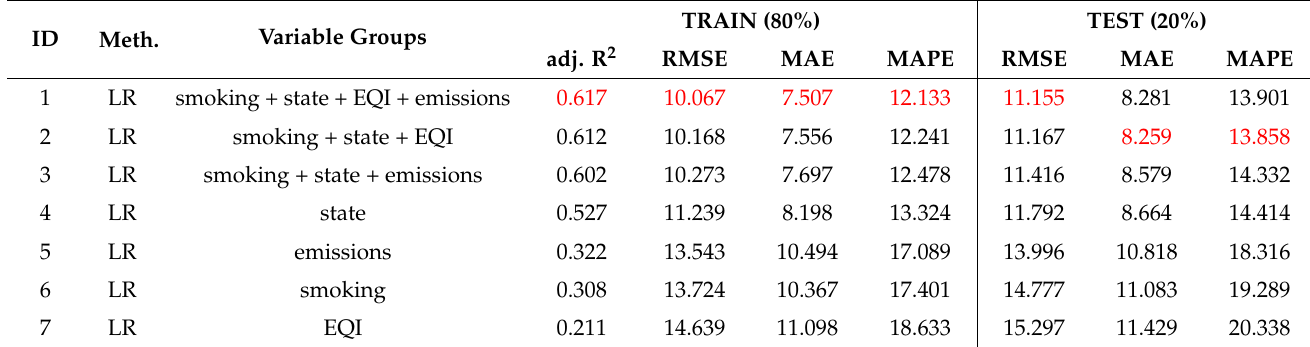
Table 5. LR: Linear Regression; RMSE: Root Mean Squared Error; MAE: Mean Absolute Error; MAPE: Mean Absolute Percentage Error.